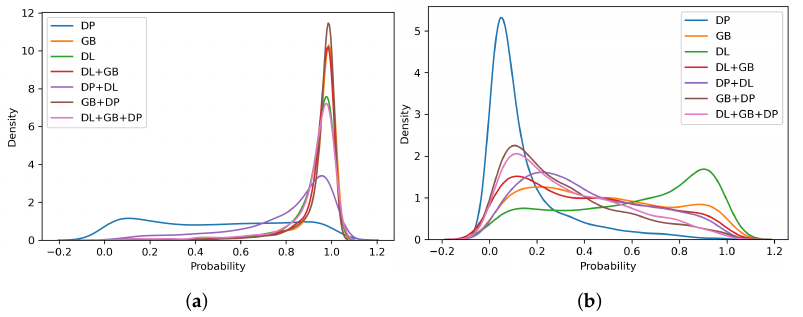
Figure 10. Probability distributions of ( a ) real and ( b ) fake fingerprint scores of the GreenBit consen- sual dataset obtained by the PAD Spoofbuster.